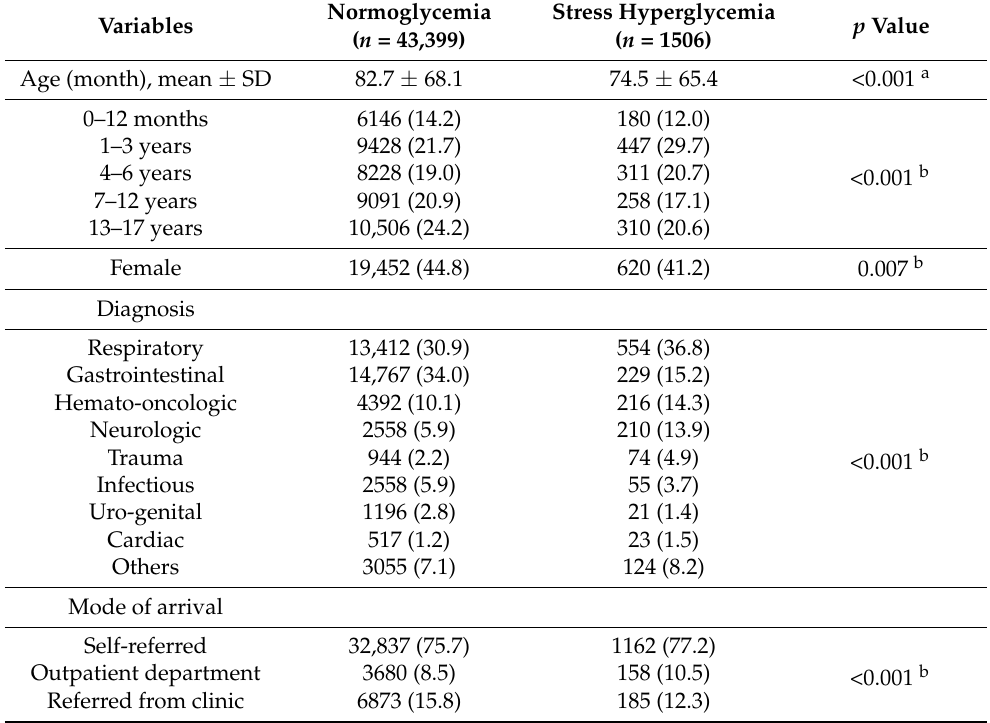
Table 1. Characteristics of patients visiting the pediatric emergency department with stress hyper- glycemia and normoglycemia ( n =